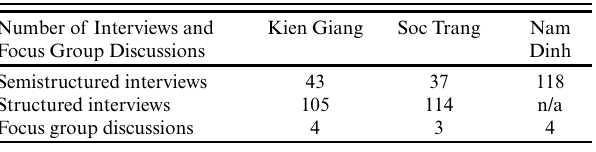
Table 2 . Number of interviews and focus group discussions per research